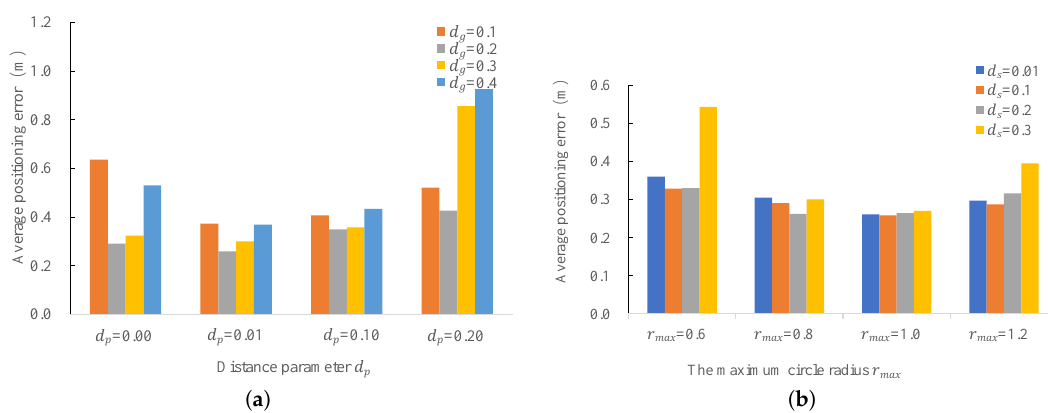
Figure 9. Positioning accuracy under the impact of different parameters of laser clustering. ( a ) Impact of different grouping thresholds d g and distance parameters d p ; ( b ) Impact of different maximum cluster radius r max and splitting threshold d s .